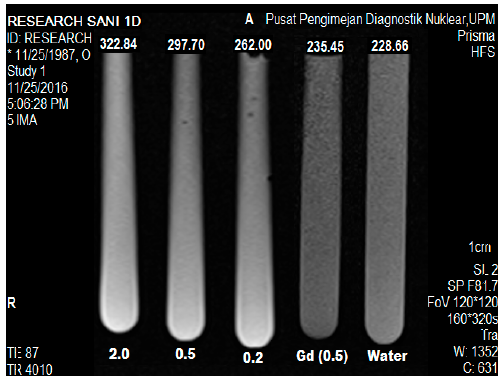
Figure 8. GAGZAu image at different Gd 3 + concentrations (2.0, 0.5, 0.2), Gd (0.5) w / v and water taken from magnetic resonance imaging MRI Prisma 3-Tesla machine.